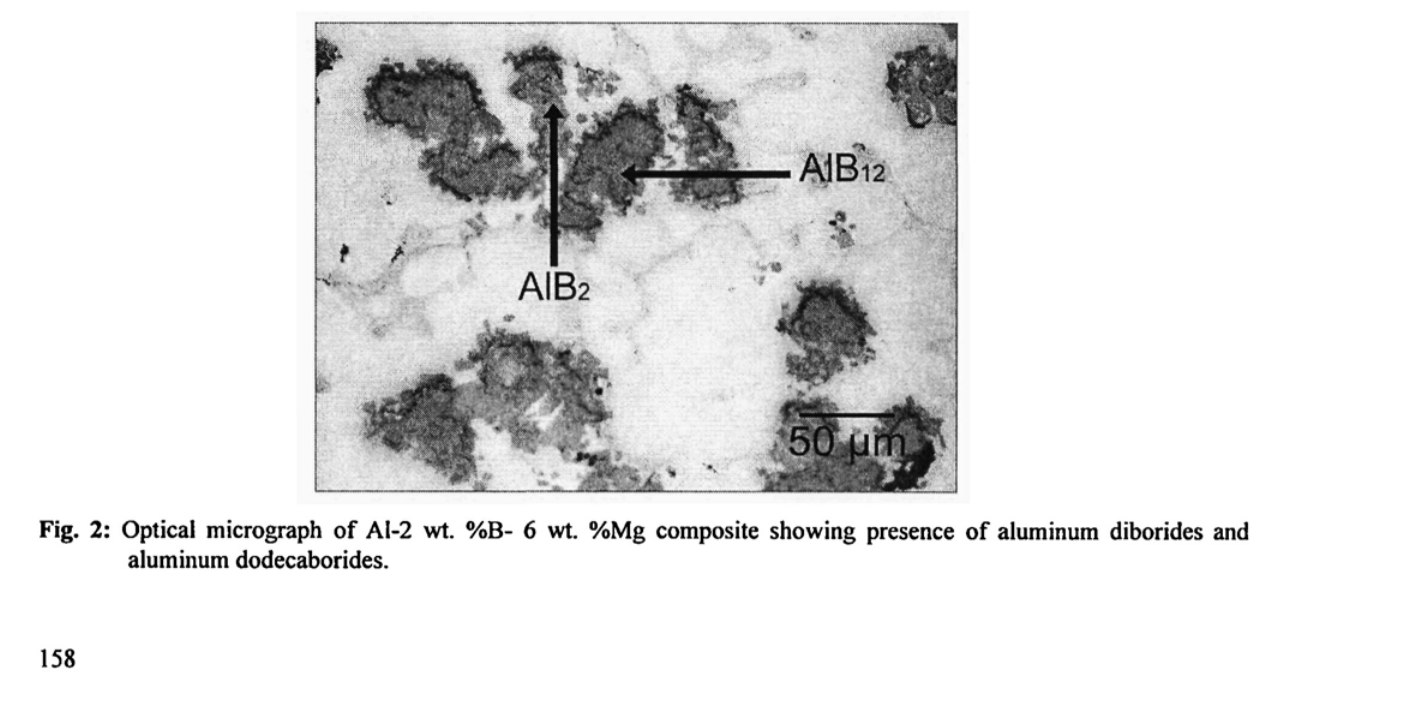
Fig. 2: Optical micrograph of AI-2 wt. %B- 6 wt. %Mg composite showing presence of aluminum diborides and aluminum